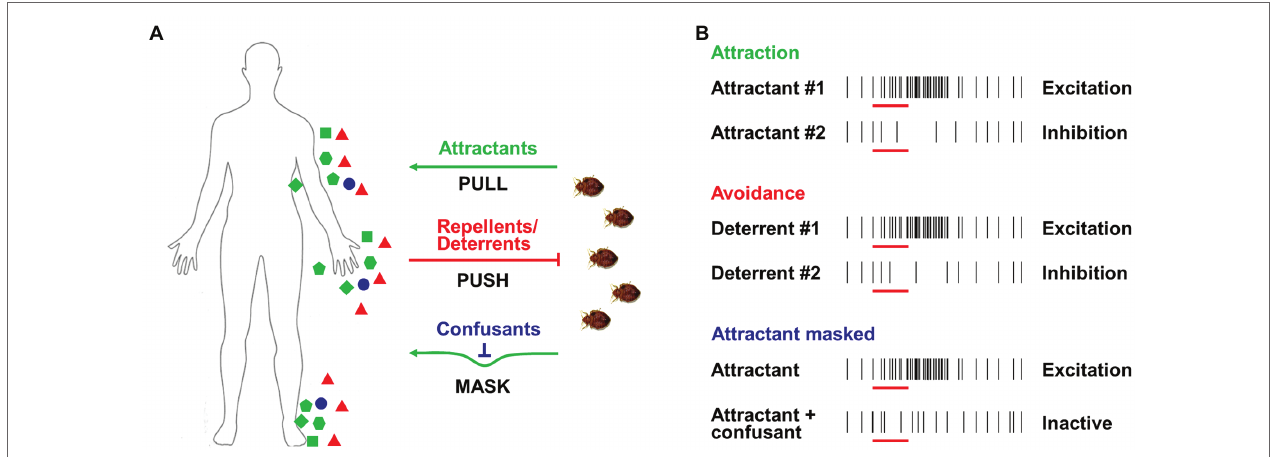
FIGURE 4 | Push-pull strategies and odor-evoked excitation/inhibition activity of ORNs. (A) Push-pull or stimulo-deterrent diversionary (SDD) strategies used for insect control; green dots indicate attractants from hosts (PULL), red dots indicate repellents/deterrents (PUSH), and blue dots indicate confusants (MASK). (B) Excitation or inhibition activities of ORNs caused by attractants, repellents/deterrents and